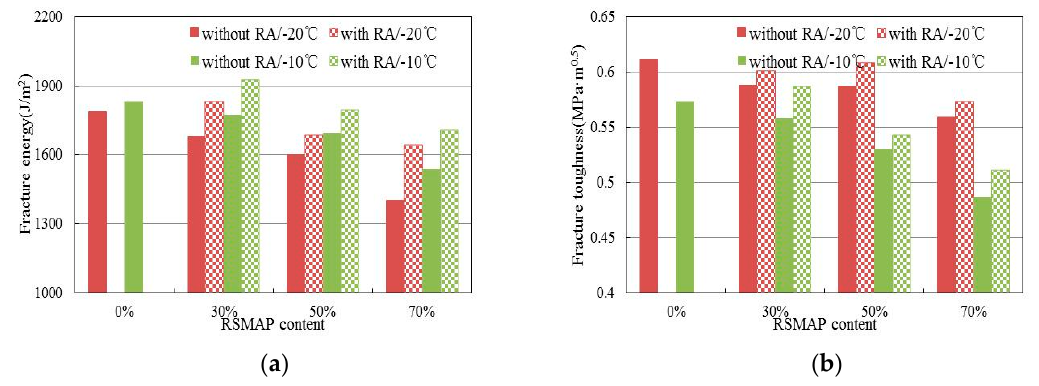
Figure 5. SCB test results of recycled mixtures. ( a ) Fracture energy; ( b ) Fracture toughness.